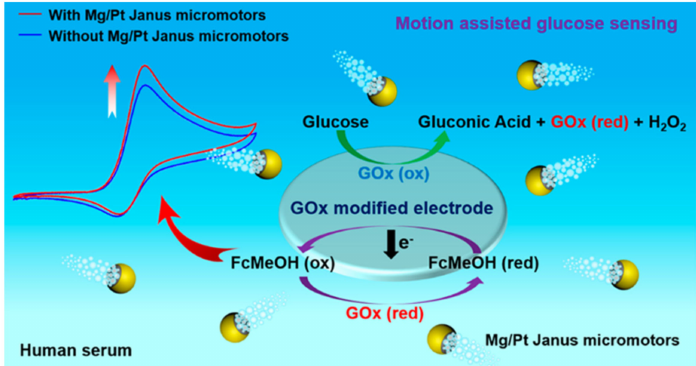
Figure 9. Schematic representation of Mg/Pt Janus micromotor-assisted glucose biosensing in human serum using screen–printed electrodes. Reprinted with permission from ref. [156]. Copyright © 2019 American Chemical